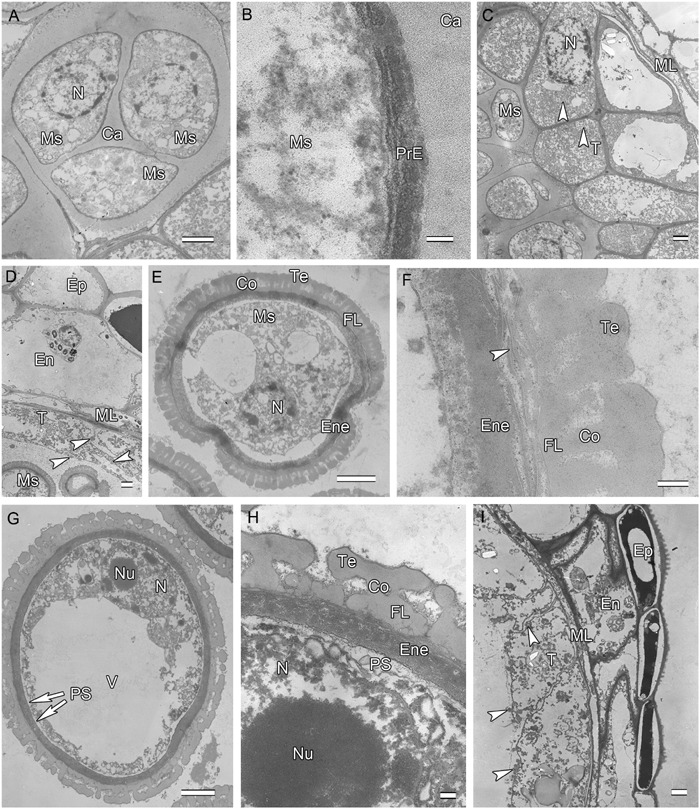
Ultra-thin sections of H. patens anthers. (A) Tetrad stage, the tetrads encased by a communal callose wall. (B) Tetrad stage, primexine matrix forms between the callose wall and the microspore. (C) Tetrad stage, showing fragmentation of nucleoli, small vesicles, and pro-Ubisch bodies (white arrowheads). (D) Uninucleate microspore stage, showing abundant Ubisch bodies produced in the tapetum (white arrowheads). (E) Showing a free microspore with differentiated wall. (F) Showing white-line-centered lamella (white arrowhead) between the FL and the endexine. (G) Vacuolated microspore stage, the nucleus is positioned against the cell wall. (H) Showing the PS formed beneath the exine. (I) Showing cell layers of the anther wall and Ubisch bodies in the tapetum (white arrowheads). Scale bars in (A,C–E,G,I) represent 2 μm, (B) represents 100 nm, (F,H) represent 200 nm.